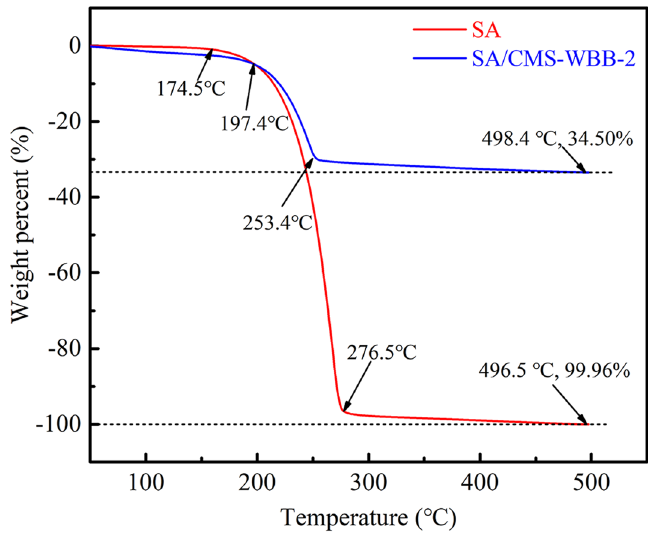
Figure 9. TGA curves of SA and SA/CMS-WBB-2.